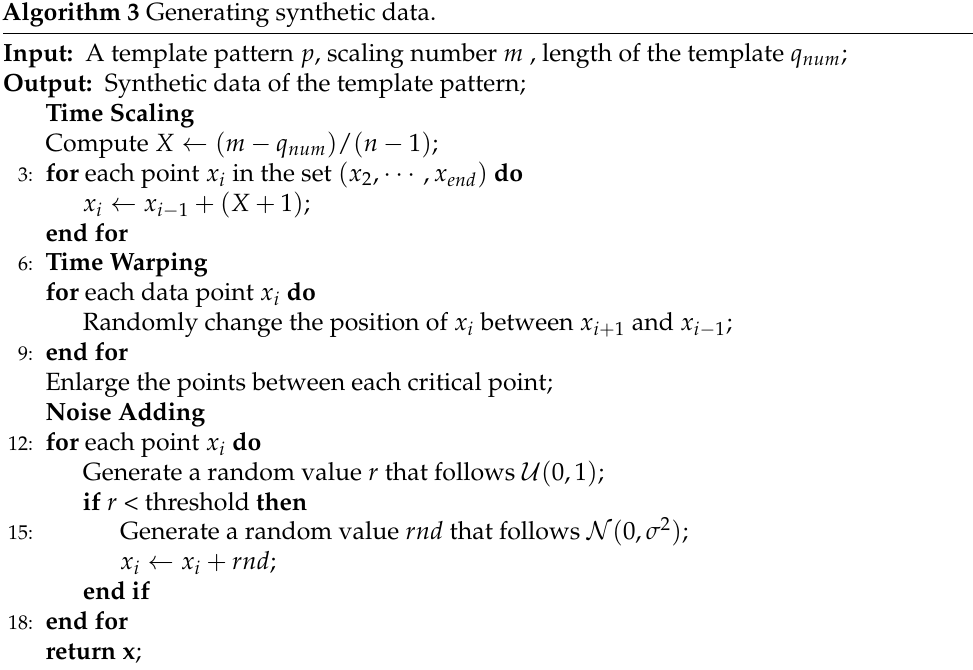
Algorithm 3 Generating synthetic data.